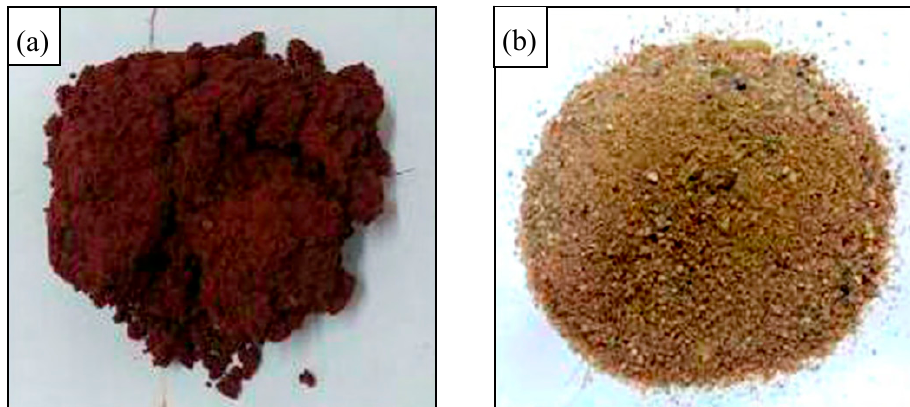
Figure 3. Typical appearance of sandy and clay soil [46]. ( a ) Clay soil. ( b ) Sandy soil. Table 1. Unsaturated parameter values.